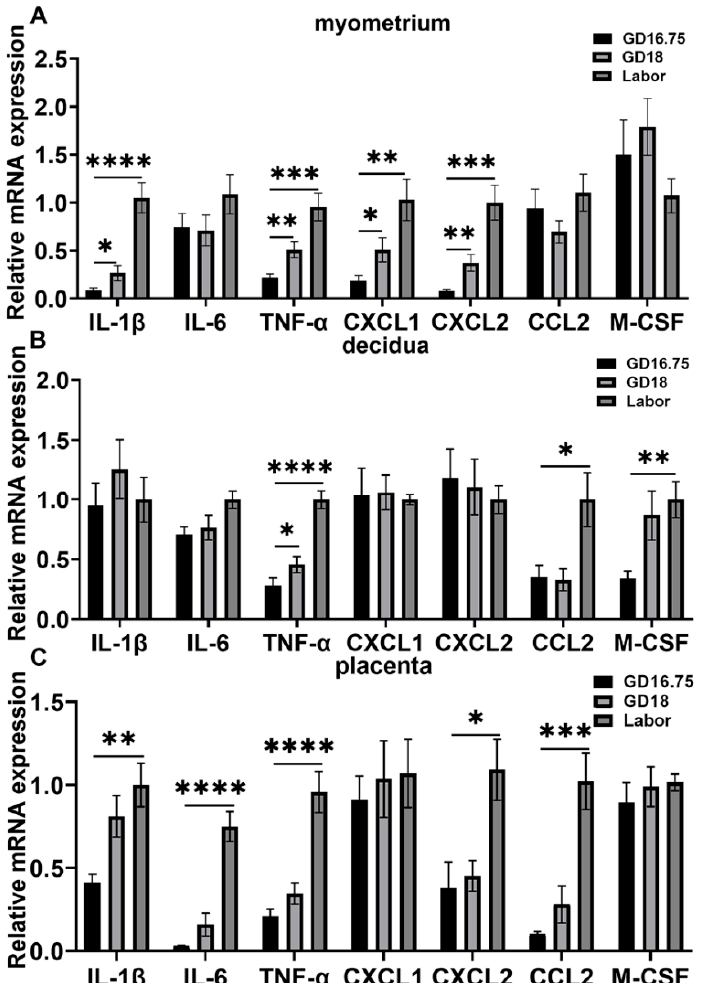
Figure 2. Dynamic changes of cytokine and chemokine expression in myometrium, decidua, and placenta from late gestation to labor. The pregnant mice were sacrificed at GD16.75, GD18, and labor. Myometrium, decidua, and placenta were obtained for determination of the mRNA levels of IL-1 β , IL-6, TNF α , CXCL1, CXCL2, CCL2, and M-GSF by Q-PCR analysis. ( A ) Cytokine and chemokine mRNA levels in myometrium; ( B ) cytokine and chemokine mRNA levels in decidua; ( C ) cytokine and chemokine mRNA levels in placenta. Data are expressed as mean ± SEM. n = 6 in each group. * p < 0.05, ** p < 0.01, *** p < 0.001, **** p <